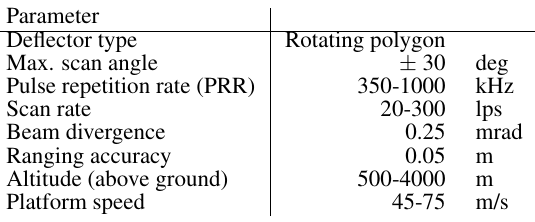
Table 1. Sensor properties and platform settings used in the